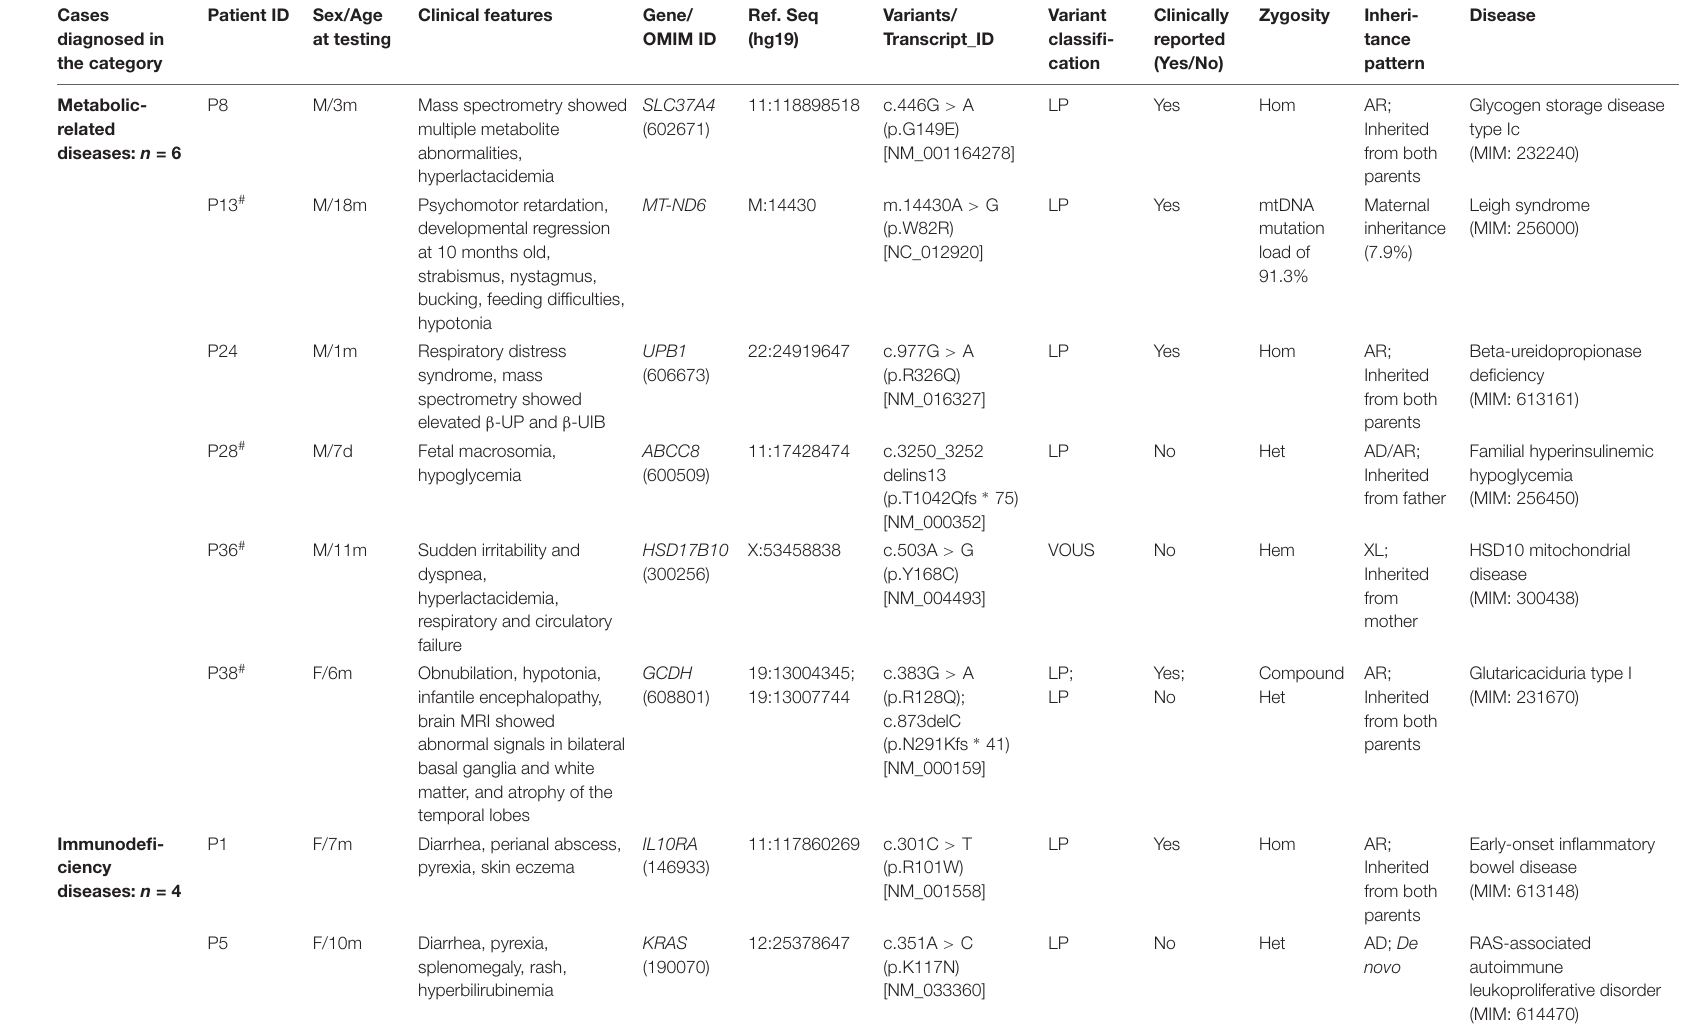
TABLE 2 | Clinical features and genetic outcome of the 18 patients